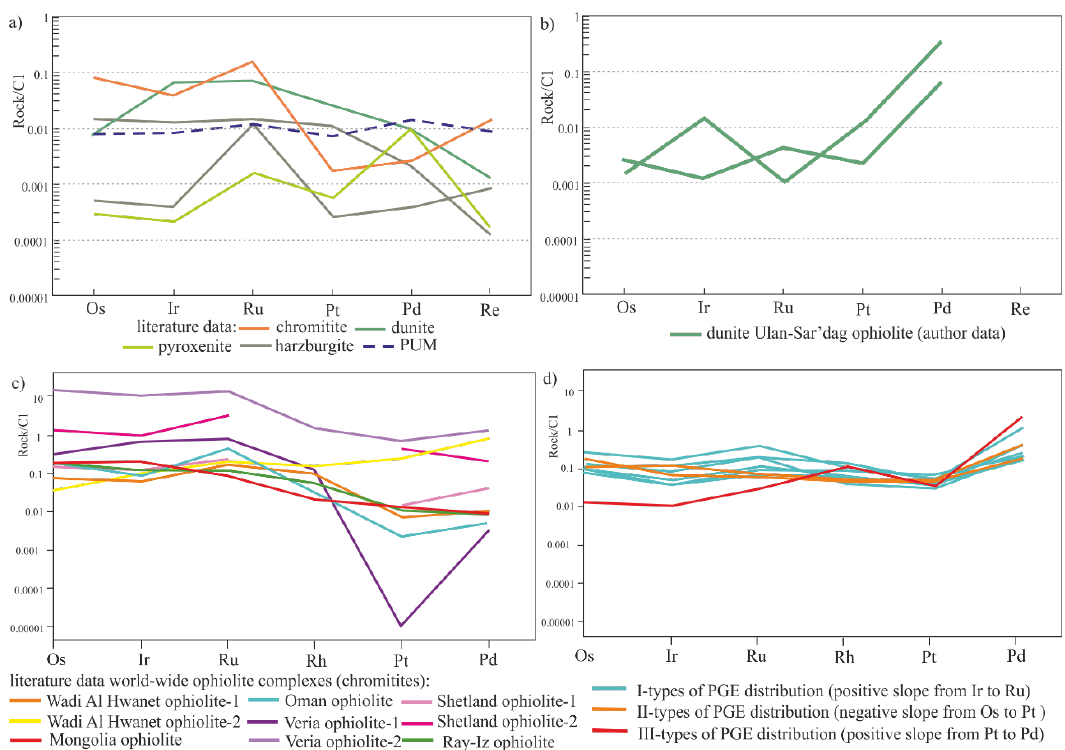
Figure 15. Diagrams: ( a ) PGE distribution in the Ulan-Sardag peridotite literature data [94]; ( b ) PGE distribution in the Ulan-Sar’dag peridotite author data; ( c ) PGE pattern of chromitites of ophiolite complexes from all over the world: The Wadi Al Hwanet ophiolite, Saudi Arabia [47]; Oman ophiolite, Semail [48]; Veria ophiolite, Greece [49]; Shetland Ophiolite Complex, Scotland [50]; Ray-Iz ophiolite, Russia [51]; Mongolian ophiolite [95]; 1—chromitites are enriched in Os-Ir-Ru; 2—chromitites are enriched in Pt-Pd; ( d ) PGE patterns in the Ulan-Sar’dag chromitites.